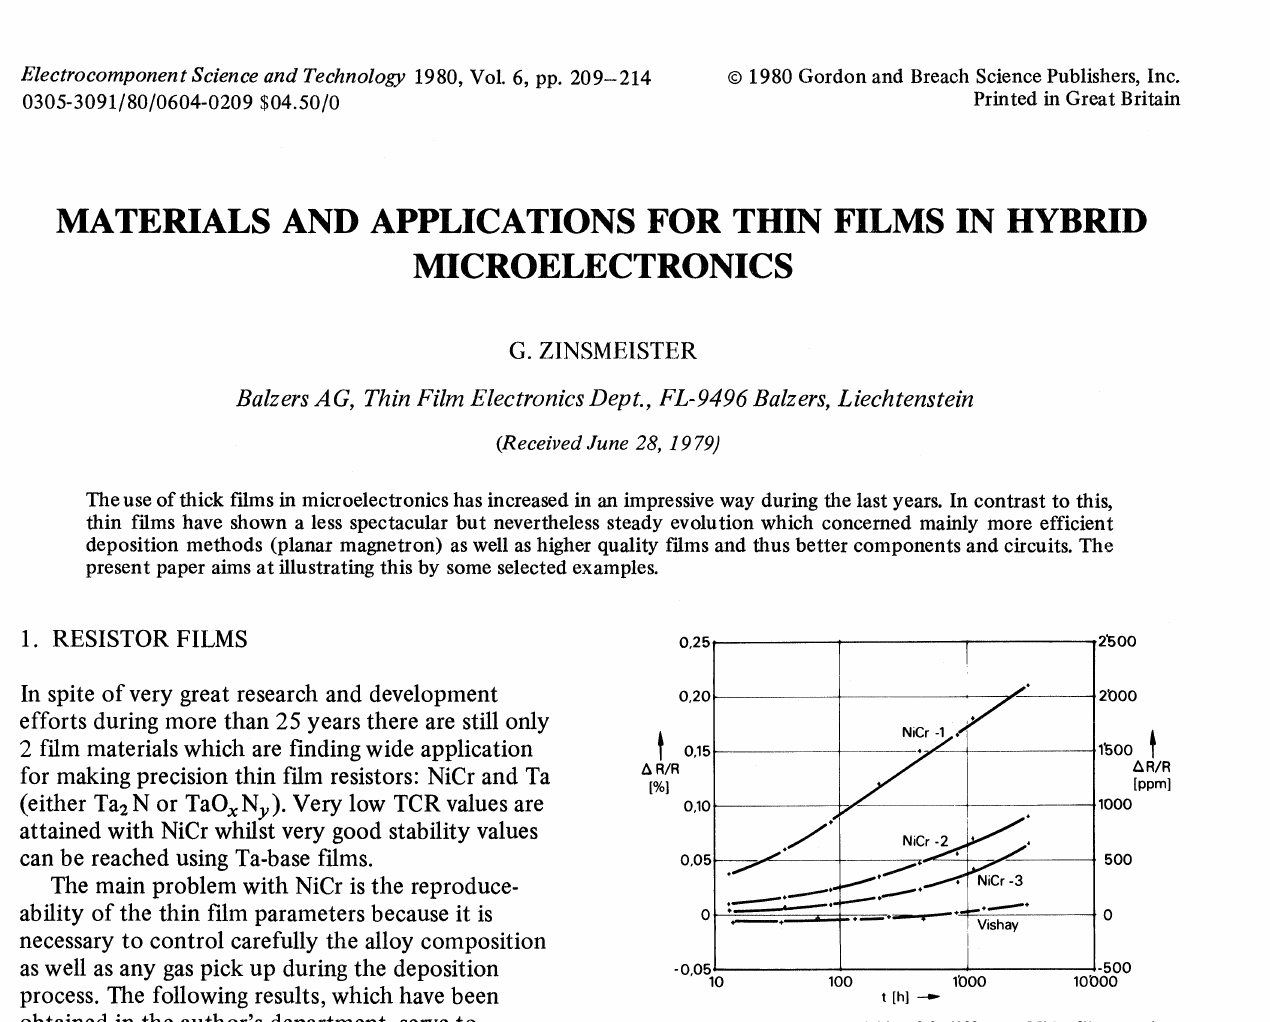
Resistance drift of 3 different NiCr fgms and a 10 k Vishay resistor at 125 C wiout load.